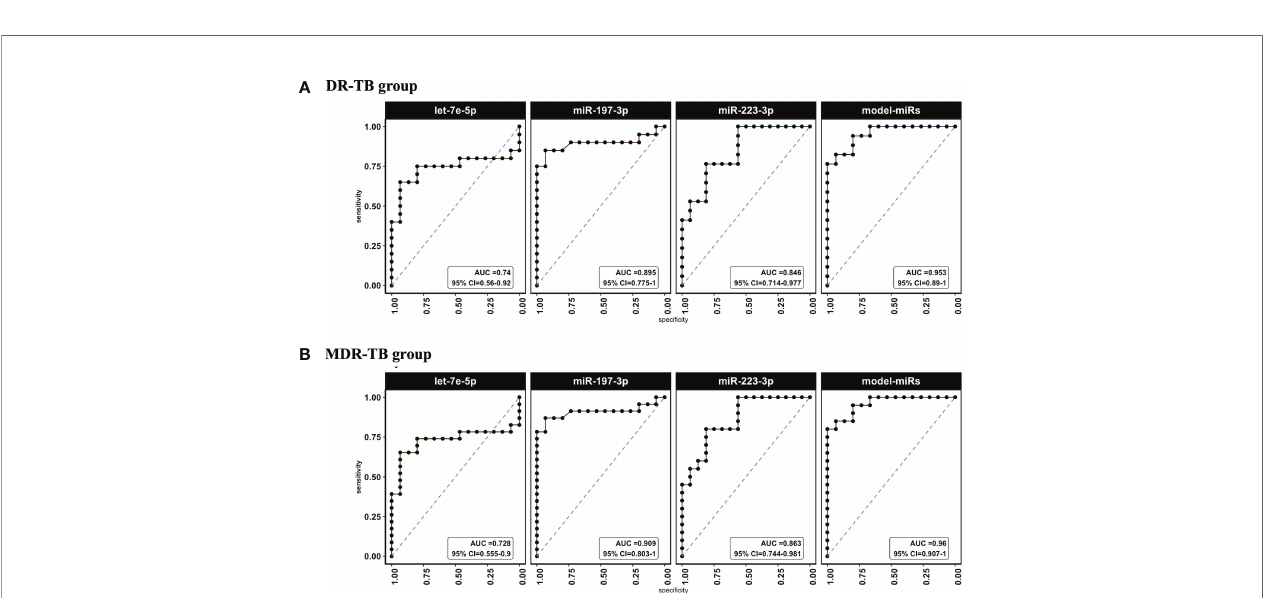
FIGURE 3 | ROC curves and AUC values for miRlet-7e-5p, -197-3p and -223-3p miRNAs in TB patients vs healthy subjects. ROC analysis was done to evaluate sensitivity and speci fi city. ROC curves were used to compare the relative expression of the three miRNAs in DR-TB and MDR-TB patients with those expressed in healthy subjects. (A) AUC and CI to miR-let-7e-5p, -197-3p and -223-3p for DR-TB patients and (B) (AUC) and CI to miR-let-7e-5p, -197-3p and -223-3p for MDR- TB patients. AUC, area under the curve; CI, con fi dence interval; ROC, receiver operator characteristic. Only statistical differences with p < 0.05 are shown.